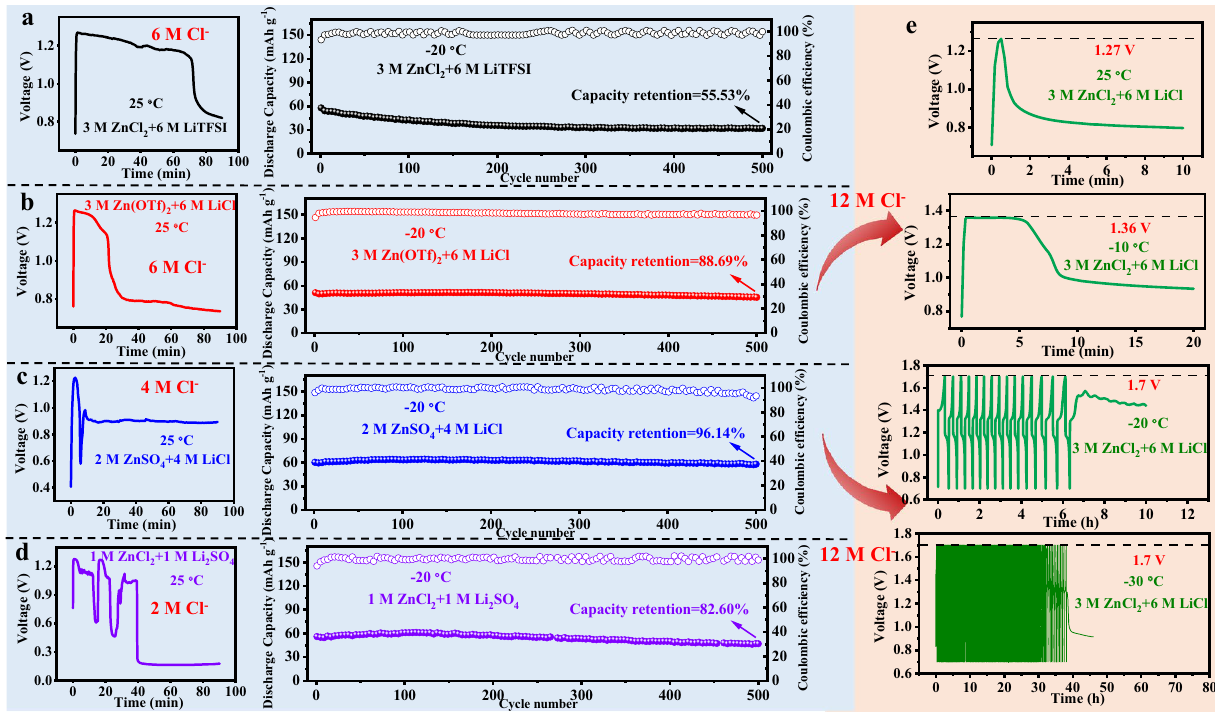
Fig. 4 GCD tests of the LiFePO 4 /Zn cells with a 3 M ZnCl 2 + 6 M LiTFSI, b 3 M Zn(OTf) 2 + 6 M LiCl, c 2 M ZnSO 4 + 4 M LiCl and d 1 M ZnCl 2 + 1 M Li 2 SO 4 hydrogel electrolytes at 25 °C and −20 °C, respectively (0.2 A g −1 ). e GCD tests of the LiFePO 4 /Zn cells with 3 M ZnCl 2 + 6 M LiCl hydrogel electrolytes at 25, −10, −20, and −30 °C (0.2 A g −1